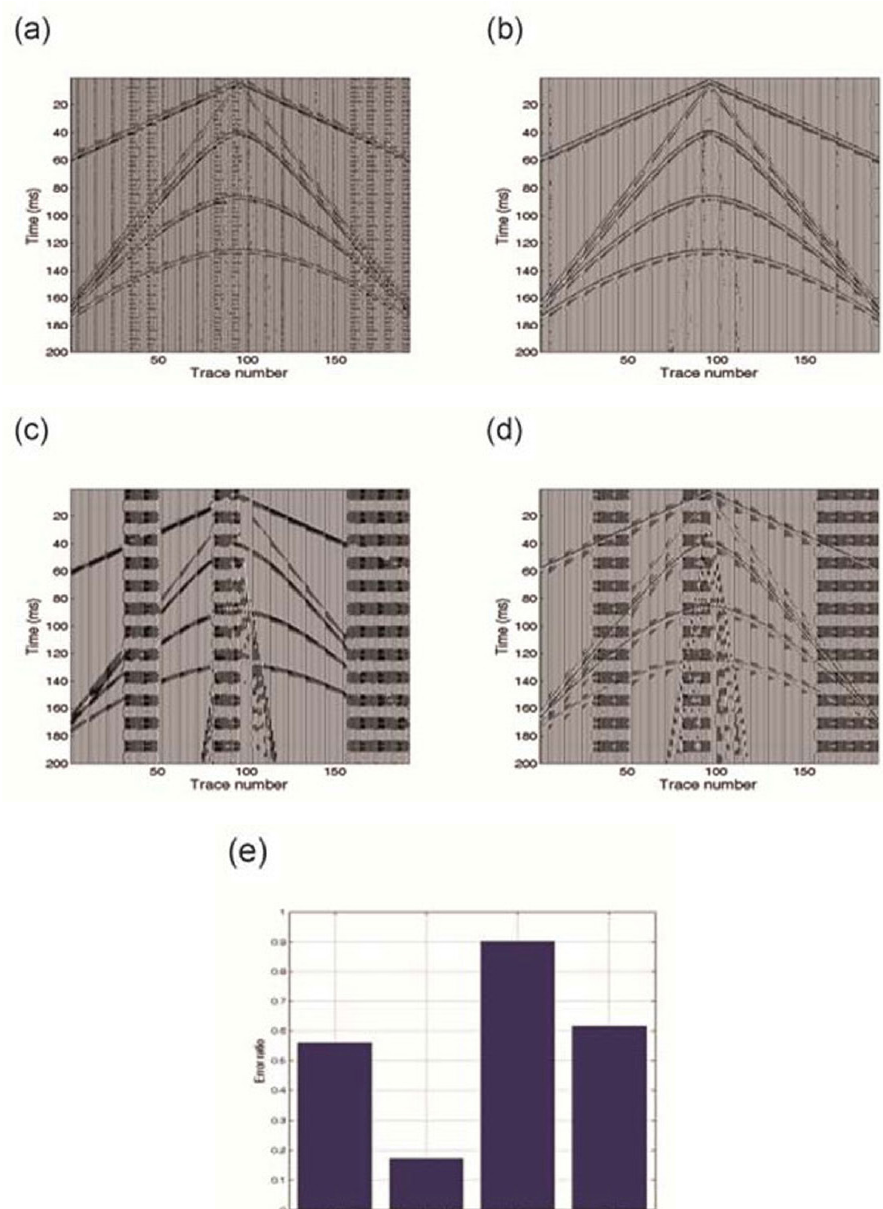
Fig. 5. Comparison of filtering results of the proposed method and other 2-D adaptive techniques to the model contaminated with harmonic noise and ground roll. The amplitudes are shown on the logarithmic scale for comparison. (a) EEMD filtering without the aid of logarithmic transform. Components IMF-2 to IMF-9 were subtracted from the dyadic filter bank to suppress the noise. (b) Logarithmic transform performed before EEMD filtering. Components IMF-3 to IMF-9 were subtracted from the dyadic filter bank in this case. (c) Result of applying the optimum 2-D median filter. (d) Result of applying the 2-D adaptive Wiener filter. (e) Error ratios of the EEMD filter, logarithmic EEMD filter, optimum 2-D median filter (2DMF), and 2-D adaptive Wiener filter